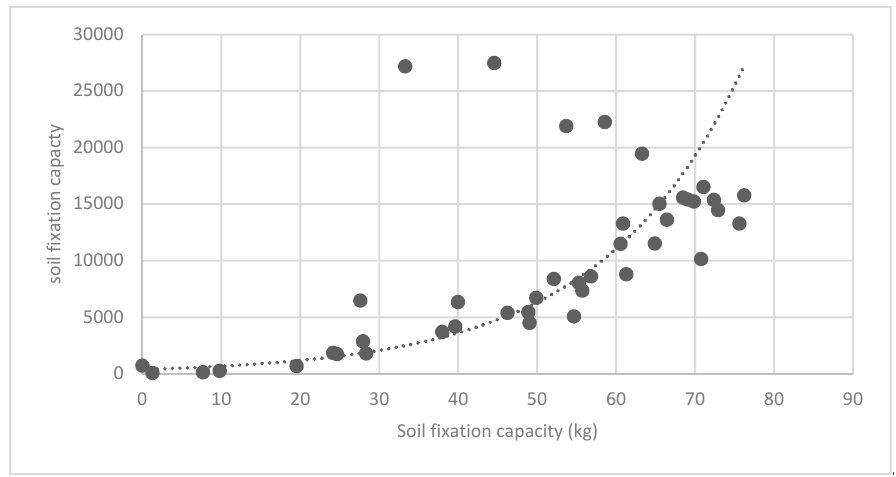
Figure 34. Association between brush LSI and soil fixation capacity.